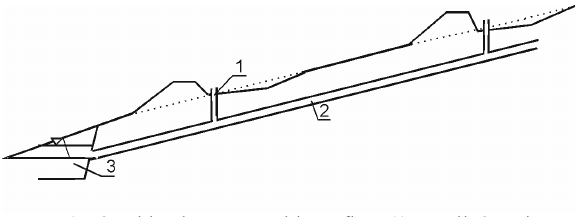
Fig. 3. Ridged terraces with outflow (1 – well, 2 – pipe, 3 –